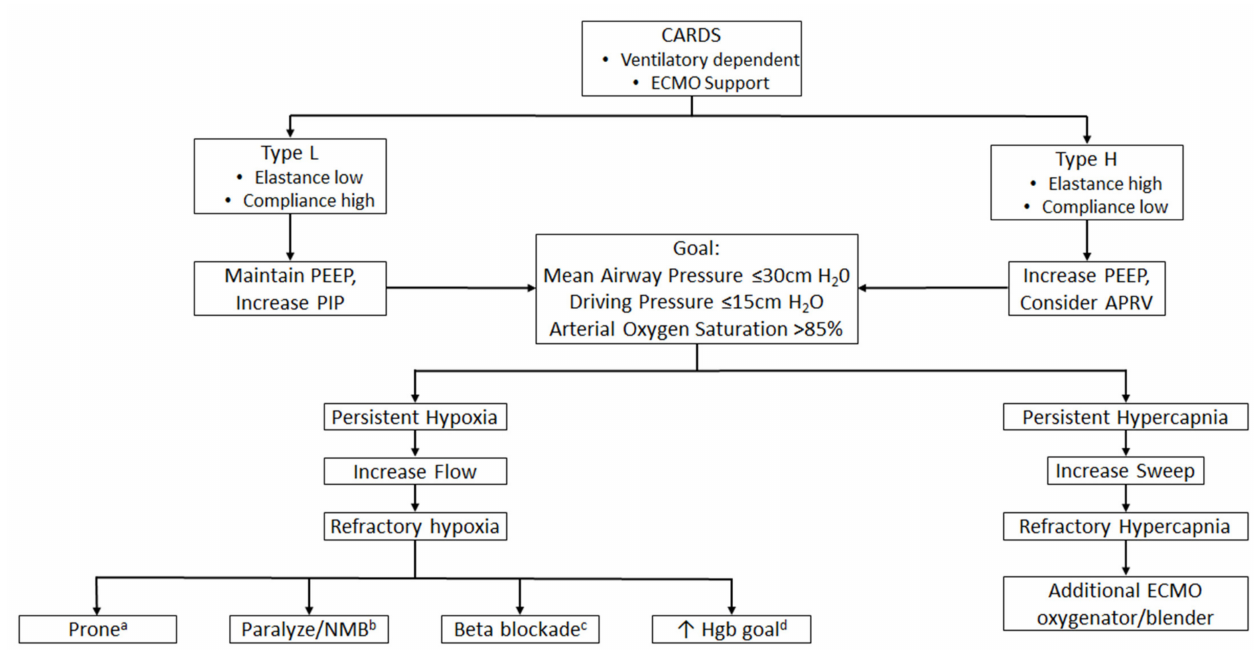
Figure 1. Ventilator algorithm for patients with COVID-19 acute respiratory. a proning: if radiographic evidence supports benefit, or if patient previously benefited from proning, prior to ECMO support. b paralysis or neuromuscular blockade: if vent dyssynchrony occurs, or if transpulmonary pressure is high due to native breaths. c beta blockade: if heart rate is above 80 beats per minute, it requires vigilant monitoring for end-organ dysfunction (e.g., lab tests such as lactate) and frequent assessments of cardiac function (i.e., bedside echocardiography). d increase hemoglobin goal: if hemoglobin is less than 9 g/dL. Legend: APRV—airway pressure release ventilation; CARDS—COVID-19 acute respiratory distress syndrome; ECMO—extracorporeal membrane oxygenation; Hgb—hemoglobin; HR—heart rate; NMB—neuromuscular blockade; PEEP—positive end expiratory pressure; and PIP—peak inspiratory